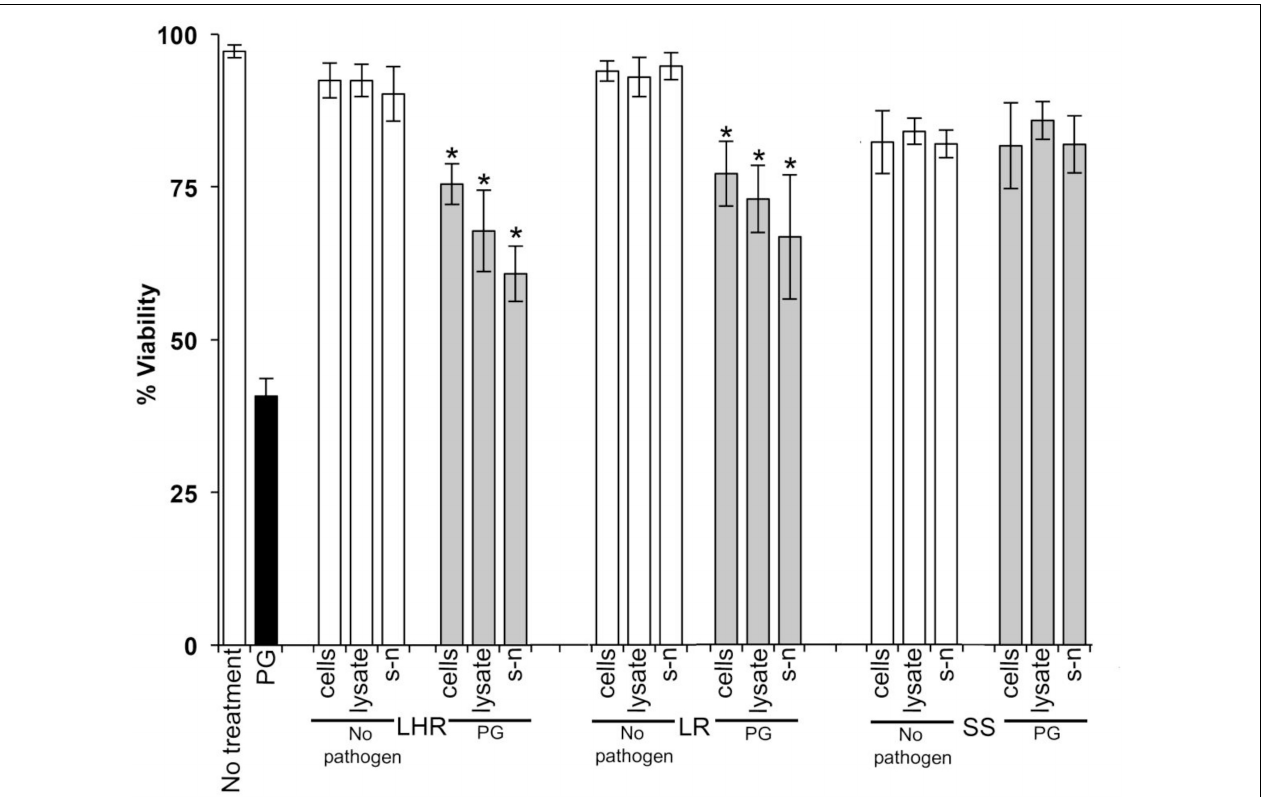
FIGURE 1 | The protective effects of candidate probiotics for human oral keratinocytes (HOKs) against P. gingivalis. All probiotic cells, cell lysates, and culture supernatants protected HOKs against P. gingivalis . HOKs were inoculated with either live L. rhamnosus GG (LHR), L. reuteri (LR), or S. salivarius K - 12 (SS) cells, lysates and supernatants (s-n) (white bars) or simultaneously in combination with P. gingivalis (PG) (gray bars). All experiments were performed for a minimum of three biological replicates, with three technical replicates each time. All data are shown as mean values plus/minus standard deviations. Results expressed as the mean ± SEM, * p <